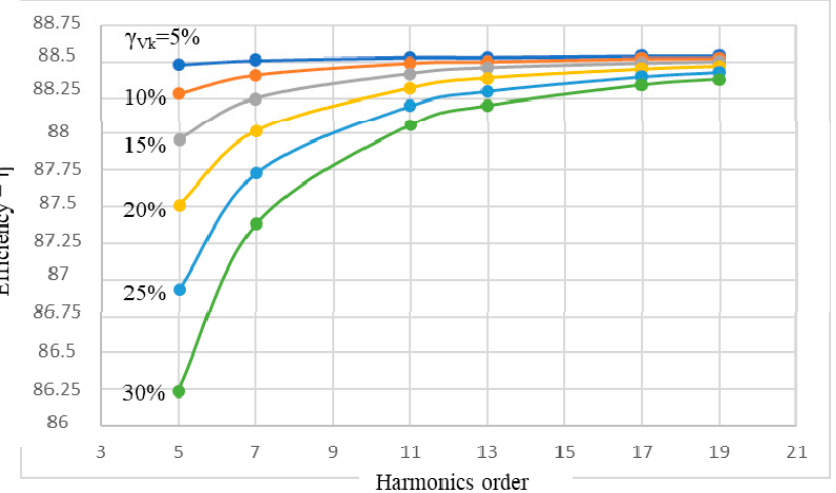
ffi ciency versus the harmonics order and their level, η (k, γ Figure 8. Variations of efficiency versus the harmonics order and their level, η (k, γ Vk ). Figure 8. Variations of e